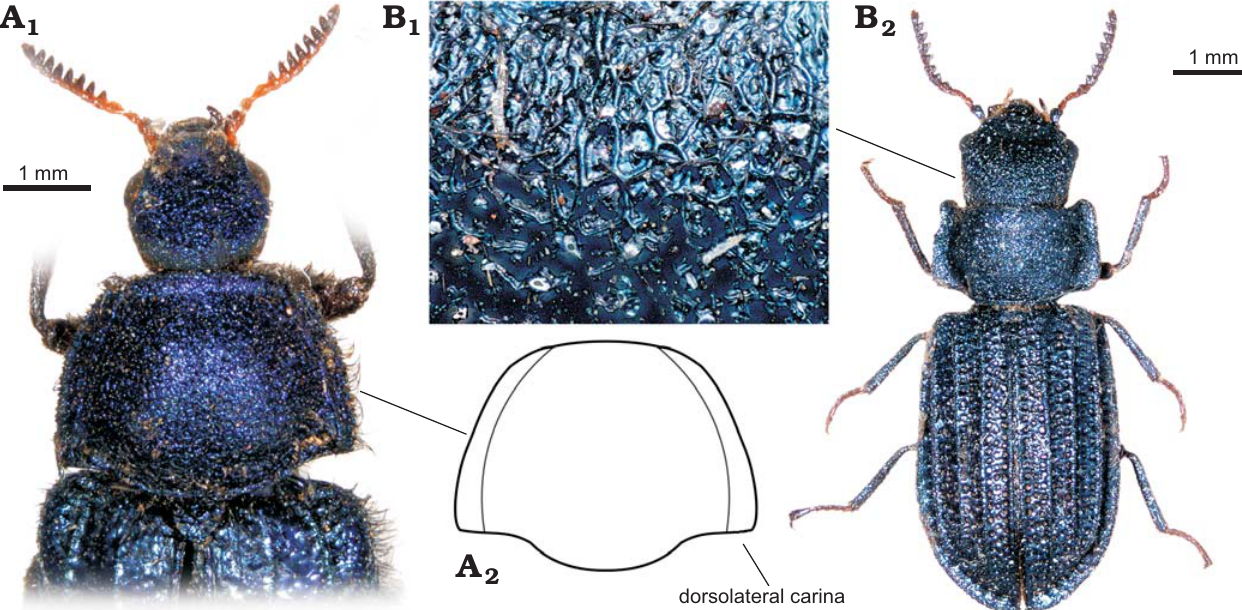
Fig. 3. Extant melyrid beetles Melyris abdominalis Fabricius, 1787 from Senegal and Falsomelyris granulatus Fabricius, 1792 (A) and from Hammoum, Algeria (B). A . MMBC-SC; base of elytra, pronotum, and head dorsally (A 1 ), outline of pronotum (A 2 ). B . MMBC-SC; detail of sculpture of head (B 1 ), dorsal habitus (B 2